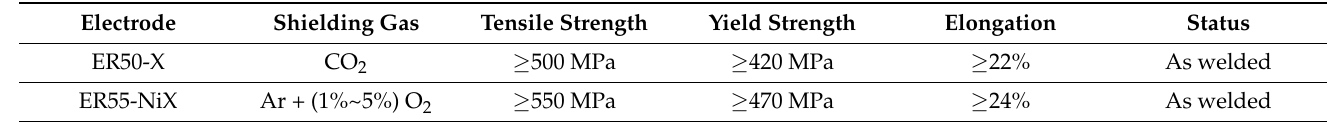
Table 7. Mechanical property demands of substrate electrode.